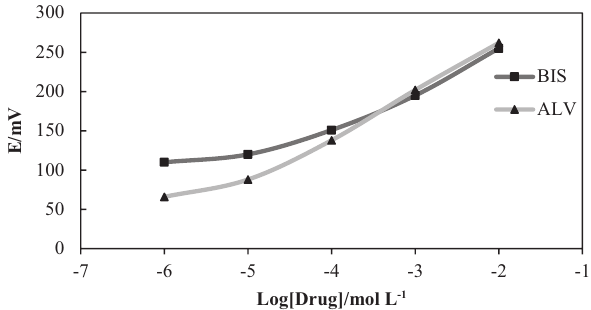
Figure 2: Potentiometric response of the BIS and ALV